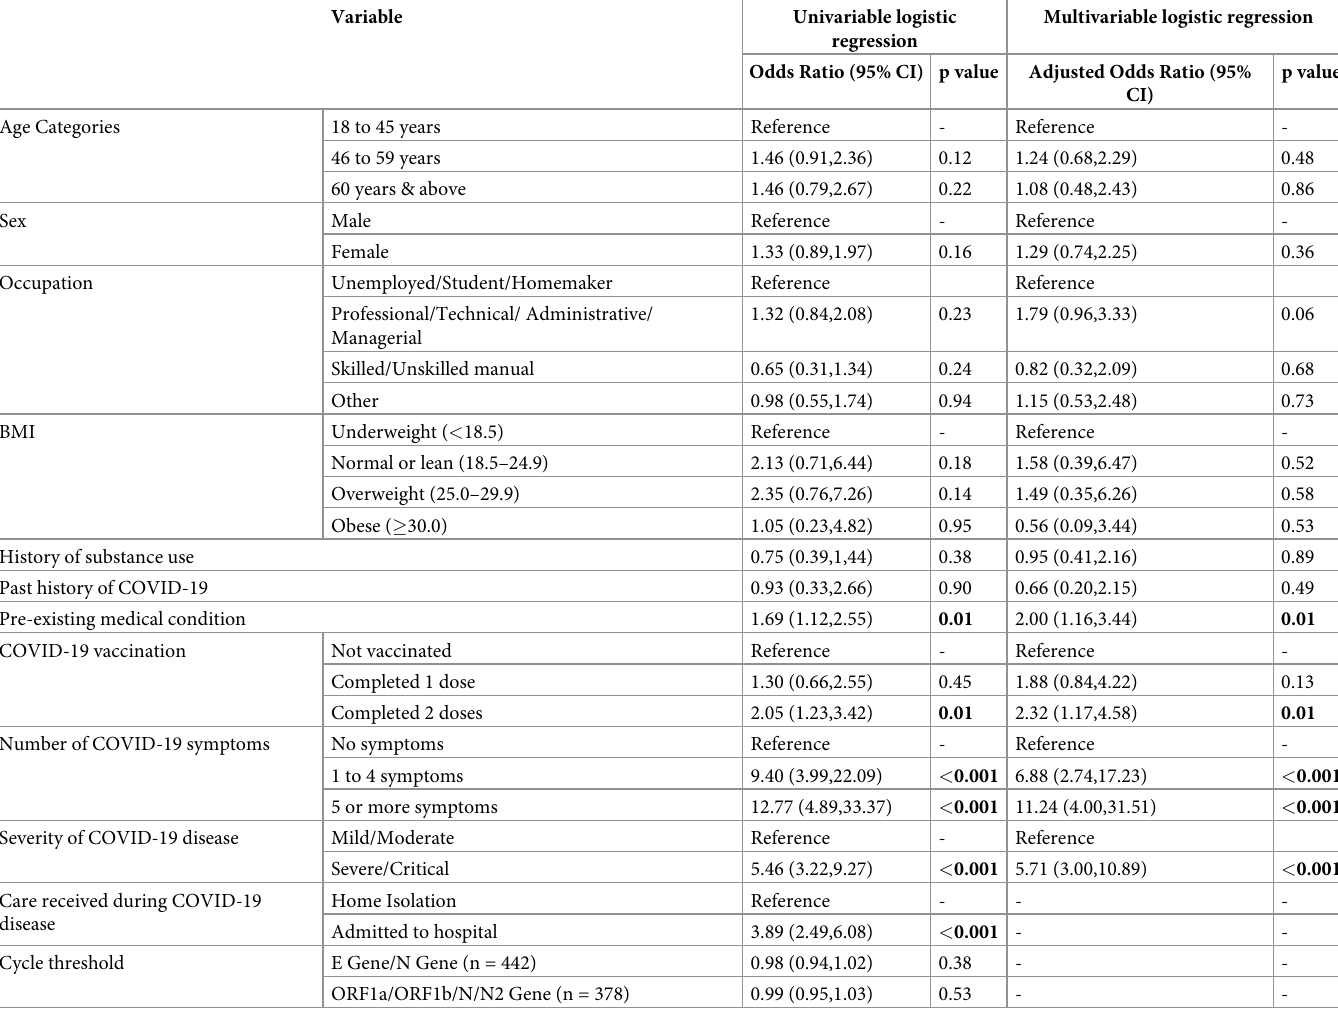
Table 4. Predictors of self-reported Long COVID symptoms at four weeks